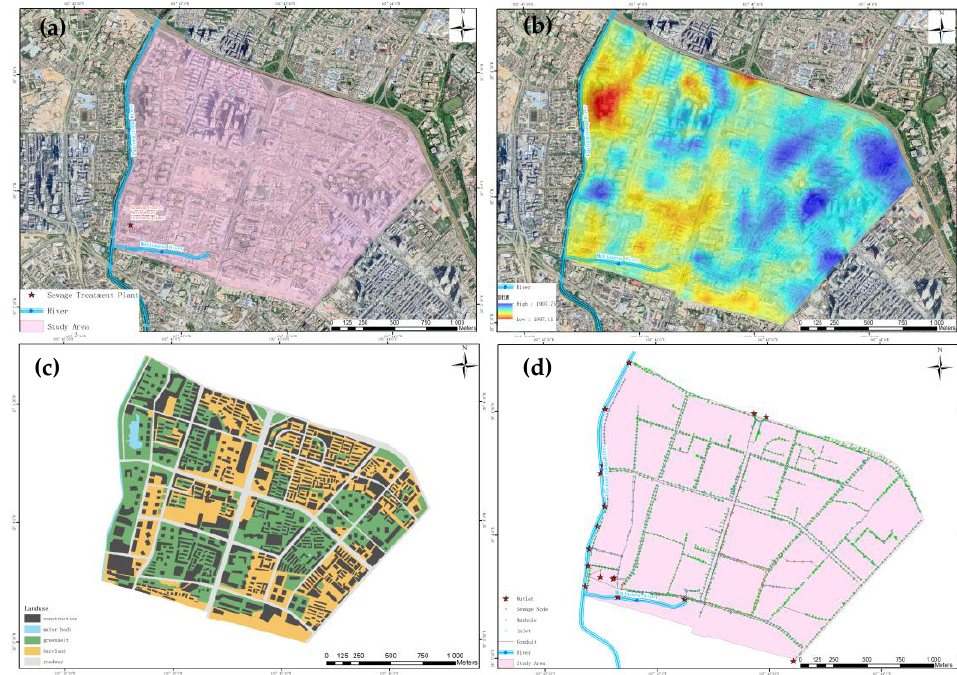
Figure 7. Location of the study area and related display. ( a ) Study area; ( b ) DEM; ( c ) land use; ( d ) distribution of network.